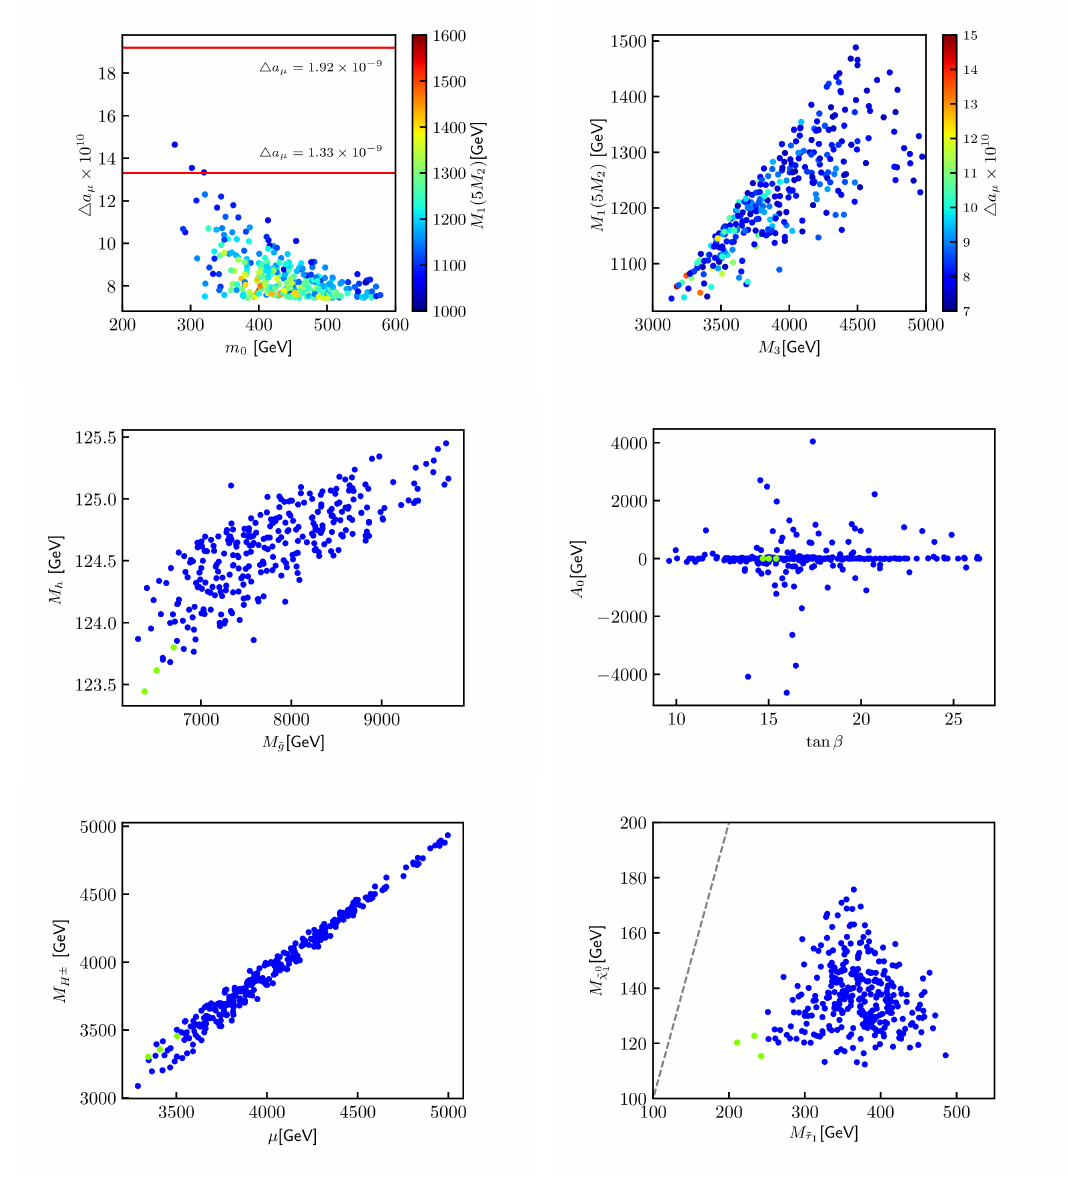
Figure 4 . Survived points in scenario (2) that can satisfy the constraints (i–vi) and give SUSY contributions to ∆ a up to the 2 σ range of ∆ a combine . In the middle and lower panels, the green µ µ (blue) points denote the survived samples that can give ∆ a SUSY in the 2 σ ( 3 σ ) µ